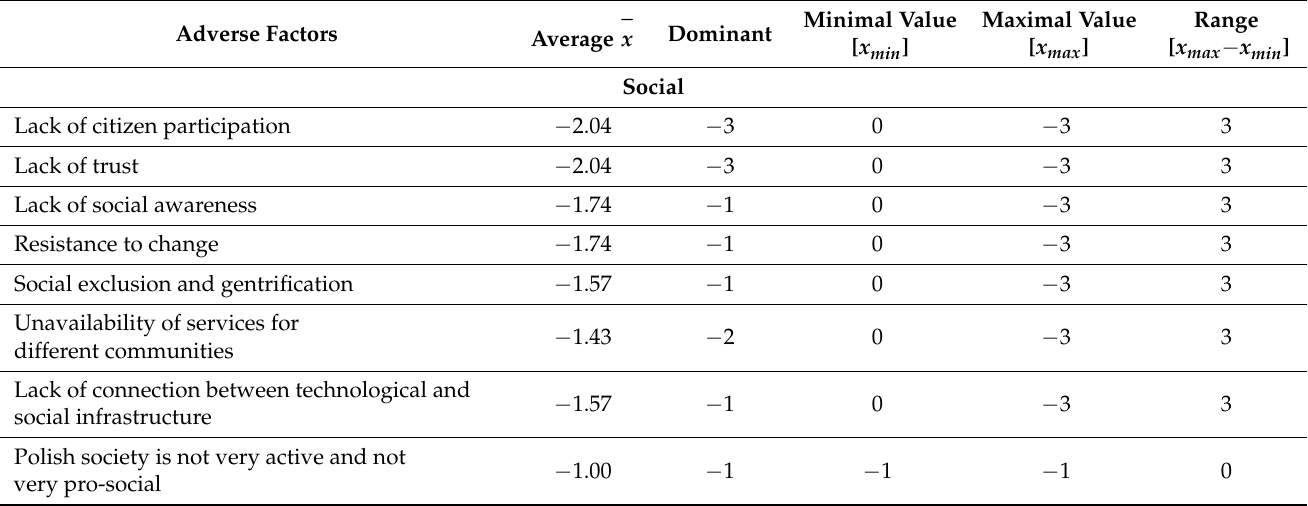
Table A3. Calculations of the descriptive statistics of the adverse factors of a smart city in Poland based on expert opinion. Source: Own